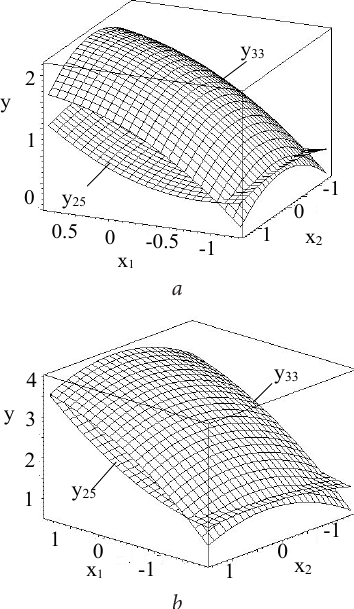
Fig. 1. The dependence of the actual water rate y on the network pressure X 1 at the degree of hose deployment X 2 : a – diameter X 3 of the nozzle at the minimum level, hose length X 4 – at the maximum level; b – diameter X 3 of the nozzle at the maximum level, hose length X 4 – at the minimum